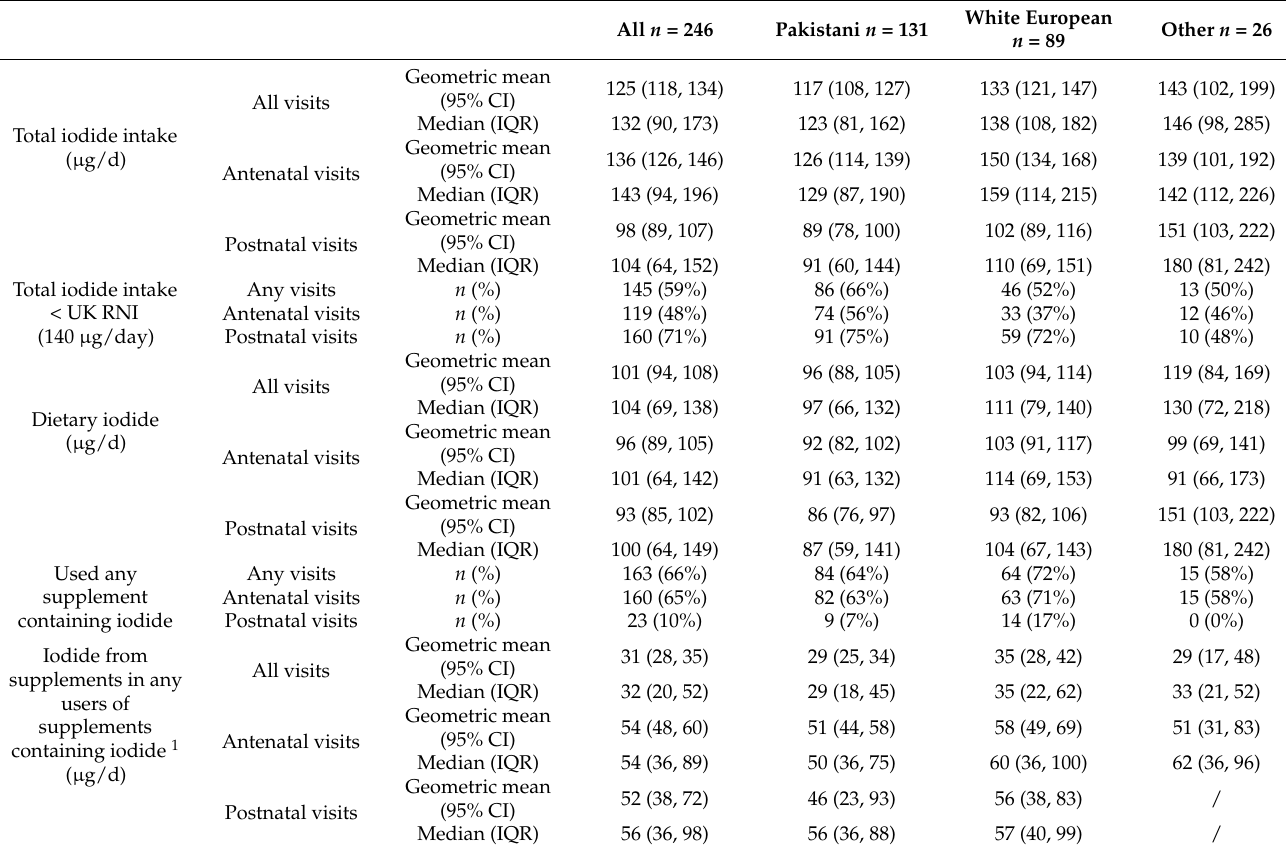
Table 3. Total, dietary and supplement iodide intake in all women and by ethnic